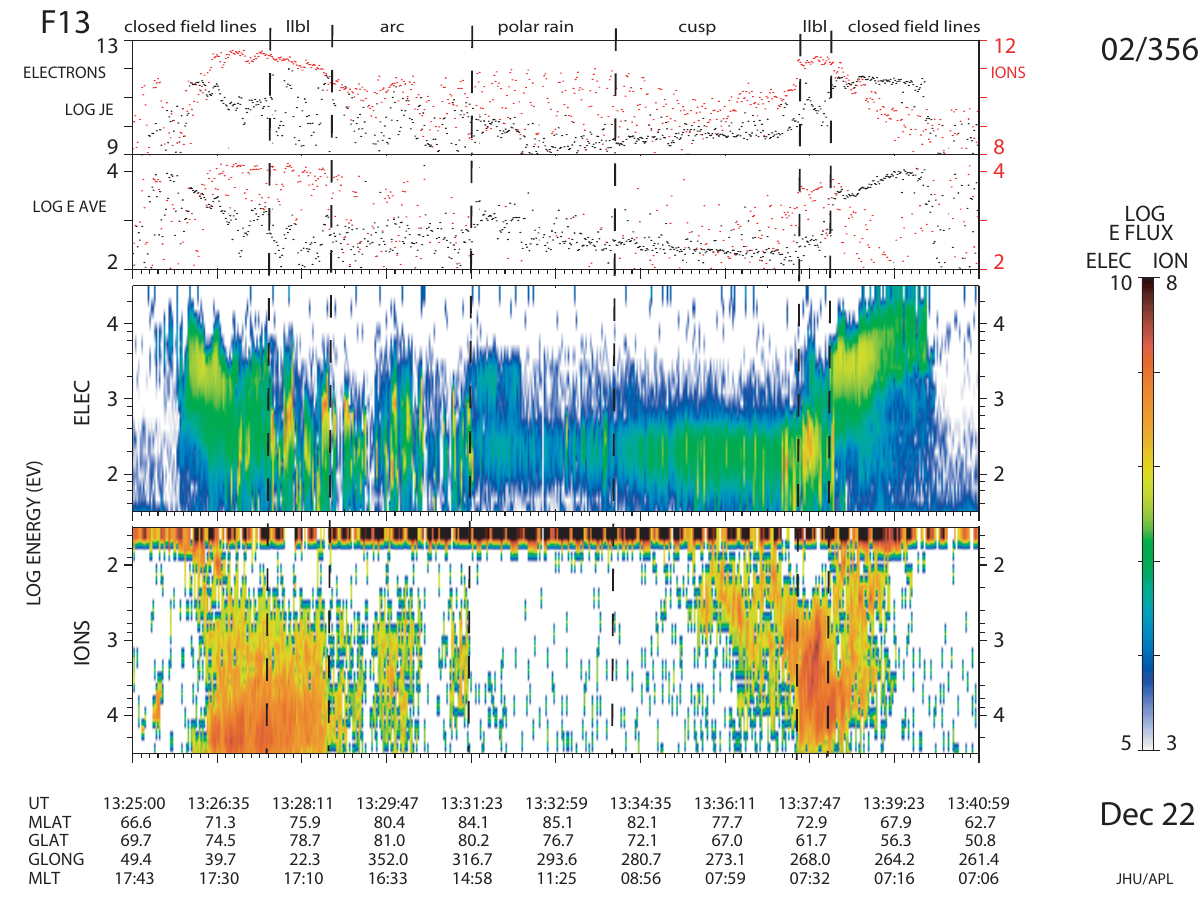
Fig. 7. Spectrogram from the DMSP F13 spacecraft for the time interval 13:25 to 13:41 UT. The black dashed lines on the plot mark the boundaries between plasma regions.